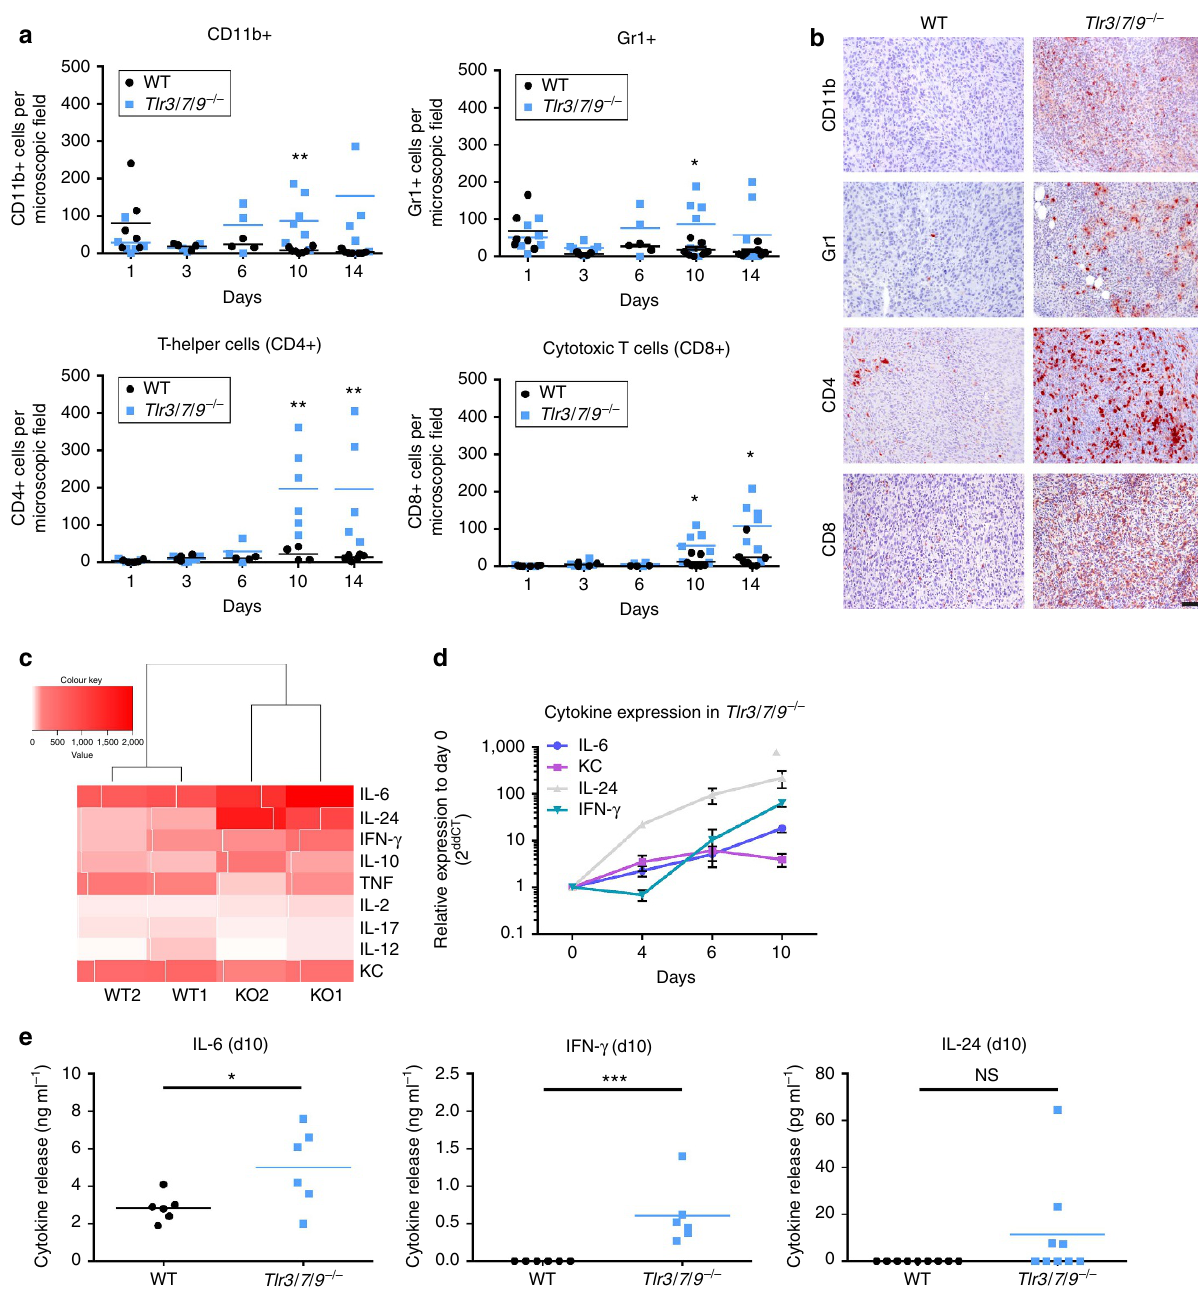
Figure 4 | Immune cell recruitment and inflammatory tumour growth in Tlr (cid:2) / (cid:2) mice. ( a ) Immunohistochemical staining of frozen tumour sections of 8- to 16-week-old C57BL/6 WT and Tlr3/7/9 (cid:2) / (cid:2) was performed to assess the frequency of tumour-infiltrating immune cells at different time points (day 1, day 3, day 6, day 10 and day 14). Quantification of the number of positive cells was performed by observer-assisted counting on four randomly selected (cid:3) 200 magnified images per sample ( n ¼ 3–7). Single values and mean (horizontal line) are shown. ( b ) Representative examples of immunohistochemical staining of tumours dissected 14 days after injection. Scale bar, 100 m m. ( c ) Hierarchical clustering of gene expression: 2 (cid:3) 10 6 MOPC tumour cells were injected s.c. into 8- to 16-week-old C57BL/6 WT and Tlr3/7/9 (cid:2) / (cid:2) mice, and tumours were dissected 6 days later. RNA was isolated and a microarray analysis was performed using an Affimetrix Chip ( n ¼ 2). Signal intensity of different cytokines is shown as hierarchical clustering. Red indicates upregulation of gene expression; white indicates no gene regulation. ( d ) Gene expression of selected cytokines was analysed in a time course by quantitative PCR: day 0 (skin only), day 4, day 6 and day 10 ( n ¼ 3 mice each). Mean ± s.e.m. of relative expression to day 0 is shown for tumours of Tlr3/7/9 (cid:2) / (cid:2) mice. ( e ) Tumours were explanted at day 10 after s.c. tumour cell injection into 10-week-old C57BL/6 WTand Tlr3/7/9 (cid:2) / (cid:2) , and cultured for 2 days in medium (20mgml (cid:2) 1 ). Concentration of IL-6, IFN- g ( n ¼ 6) and IL-24 ( n ¼ 9) in the SNs was analysed. Single values and mean (horizontal line) are shown. Results were considered significant at * P r 0.05, ** P r 0.005 and *** P r 0.0005 ( t using RNA microarrays. Evaluation of cytokine gene expression were then further investigated in a time course and on the protein suggested an induction of interleukin (IL)-6, IL-24 and interferon level (Fig. 4d,e). In agreement with the previous findings, (IFN)- g in KO over WT animals (Fig. 4c). These candidate genes induction of IL-6 and IL-24 started between day 4 and day 6,